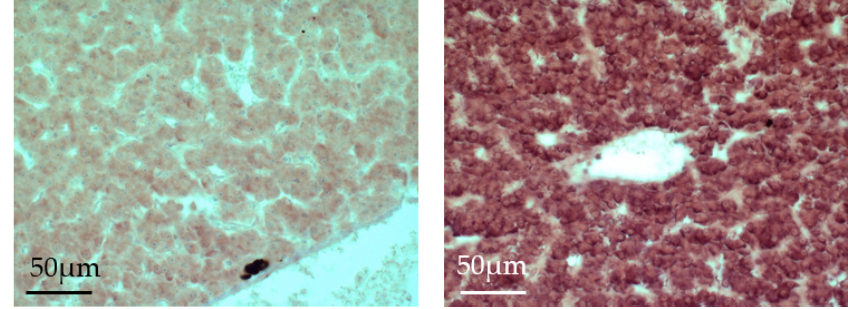
Figure 3. In situ hybridization of the ER α 1 mRNA in the liver of juvenile rainbow trout. Detection of the hybridization product was done using ER α 1 probes on liver sections of control ( left ) and E2-exposed ( right ) juvenile rainbow trout and detected with NBT-BCIP (dark-purple). 2.3. Changes of ER Gene Transcript Levels in Sexually Mature Adult Rainbow Trout Females during the Reproductive Cycle